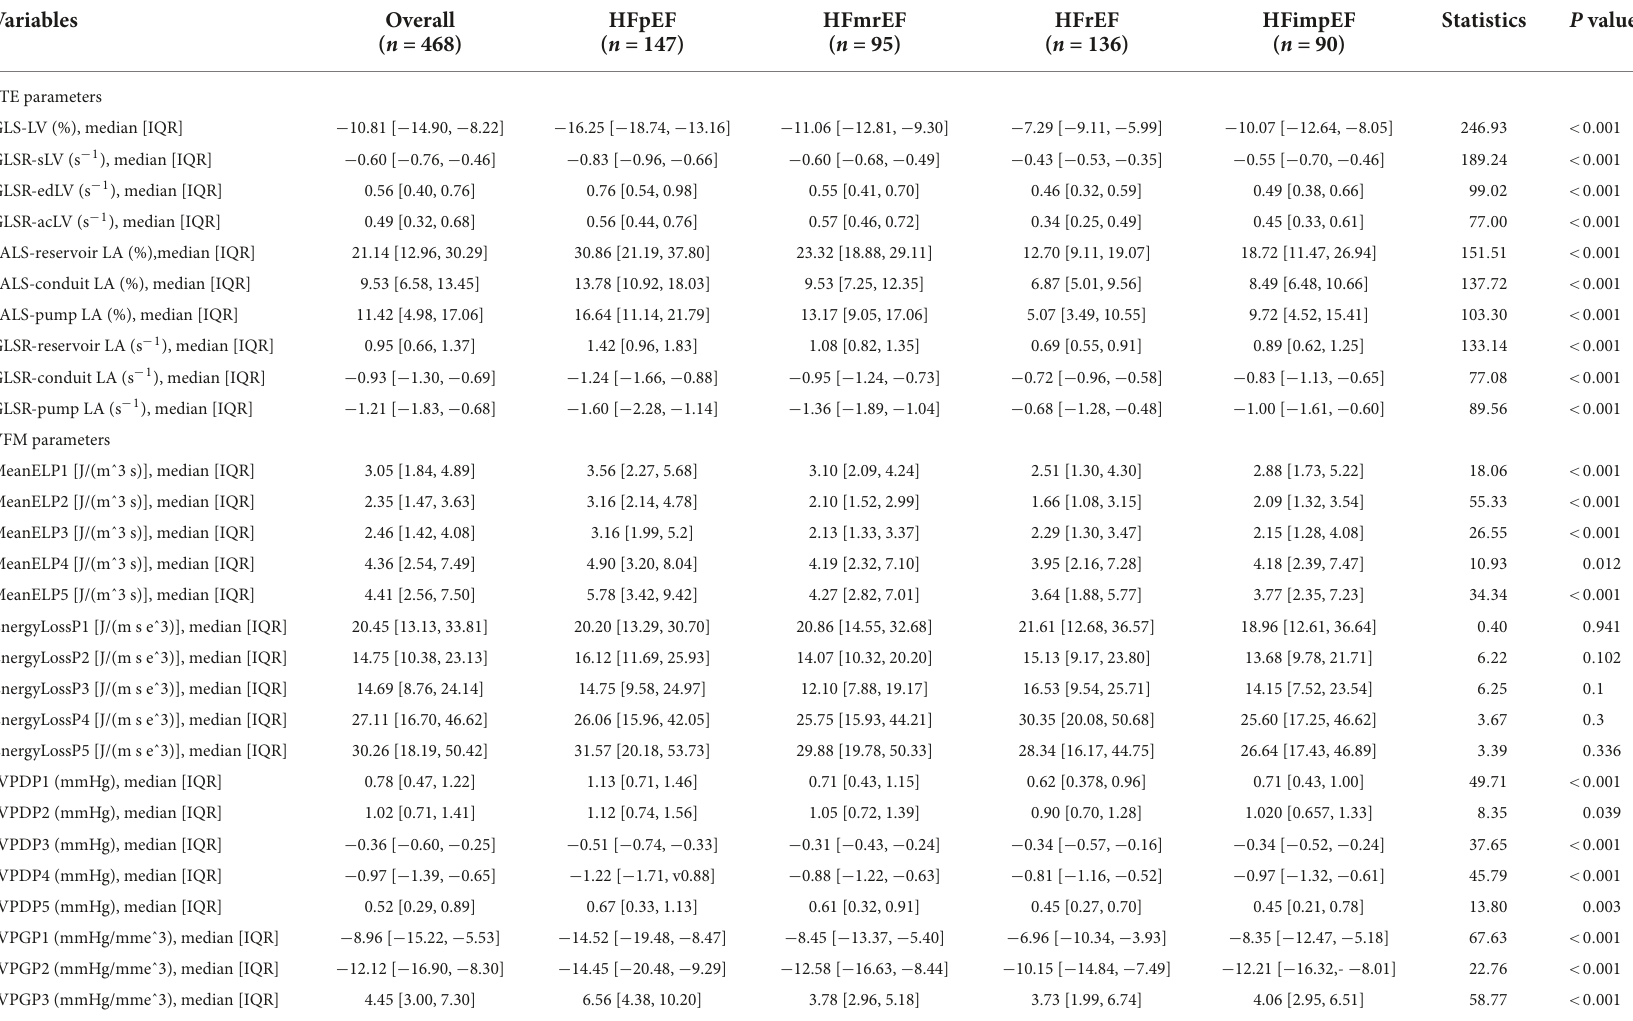
TABLE 4 Echocardiographic characteristics of speckle tracking echocardiography (STE) parameters and vector flow mapping (VFM) parameters divided by left ventricular end fraction (LVEF) classification.